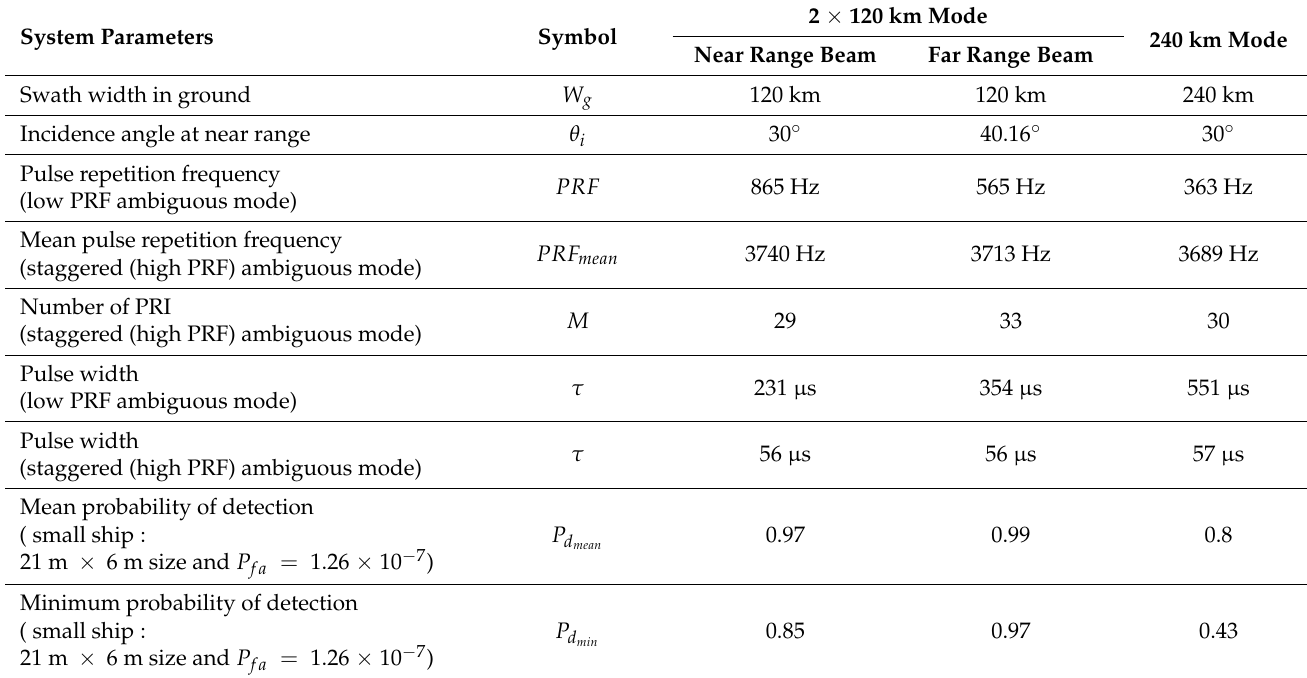
Table 3. System and main performance parameters of the ambiguous mode